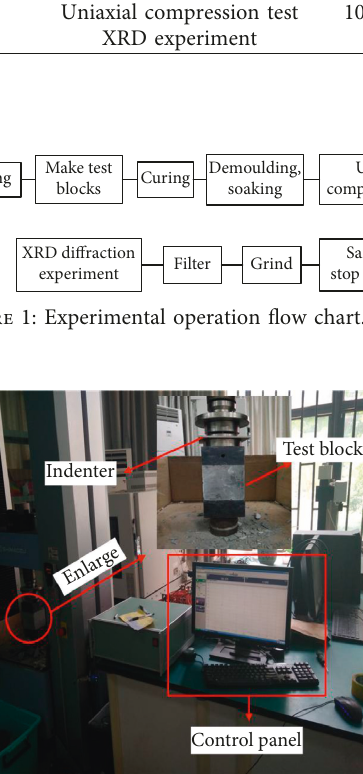
Figure 2: Uniaxial compression test.